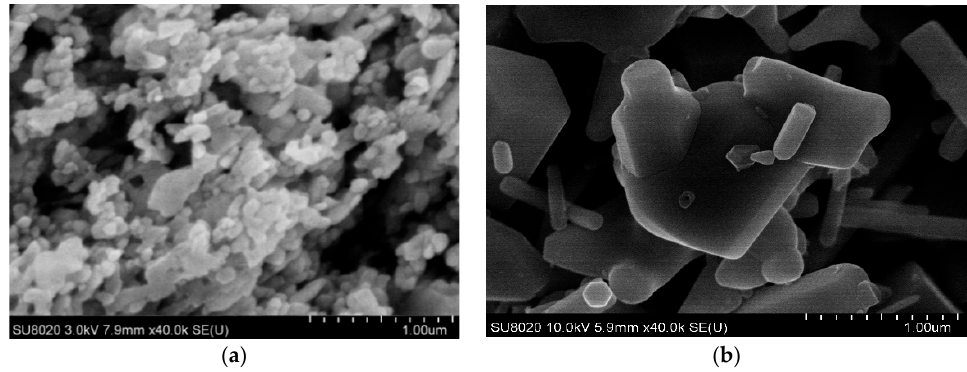
Figure 4. Morphology characterization of ( a ) Nano-ZnO (40 nm); ( b ) Micro-ZnO (1 µm).